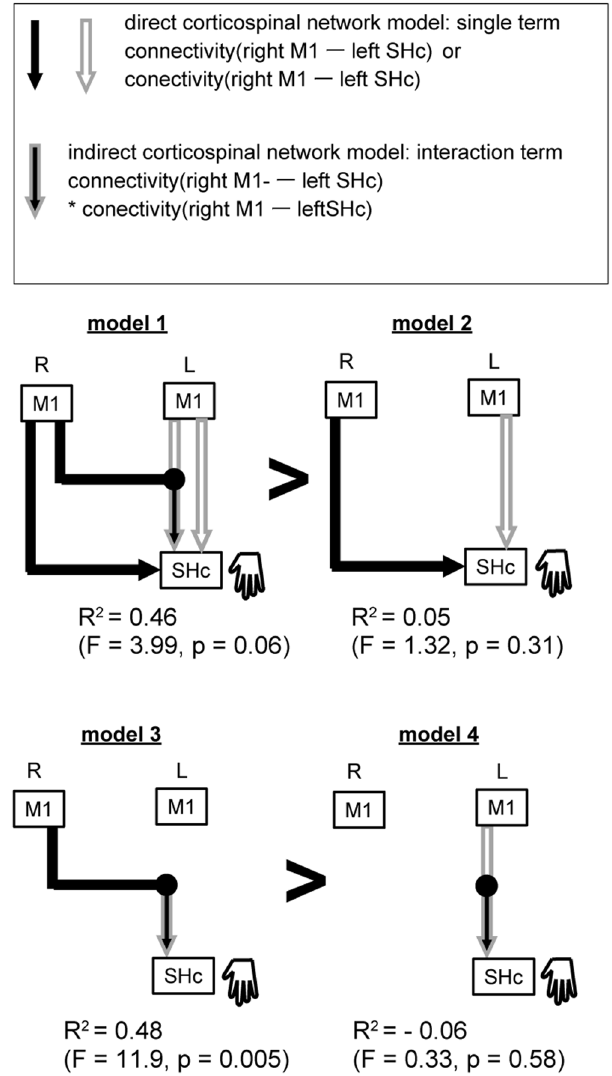
Fig. 3 Network models of SHc activity during LHM with single or interaction terms. Single terms (black line and white line with gray outline) and interaction terms (black line with gray outline) in the connectivity model. According to structural equation modeling, single and interaction terms modulated by contralateral M1 activity or ipsilateral M1 activity were used to model the direct and indirect corticospinal networks. Model 1 is the full model that contains the two interaction terms and model 2 only contains the two single terms. See Supplementary Fig. 8 for model equations. The R 2 values were adjusted (see “ Methods ”